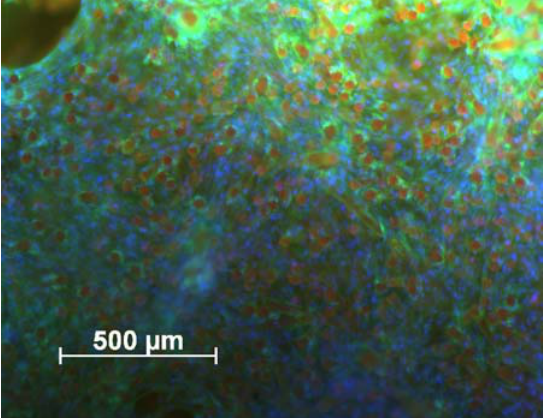
Figure 9. cLSM image of the scaffold surface 28 days after cell seeding. Cells were stained with DAPI/phalloidine. Actin fibers of cells appear green and nuclei of cells blue. Fibers of flock scaffold show up red because of their autofluorescence. The cells are distributed homogeneously over the surface. Scale bar represents 500